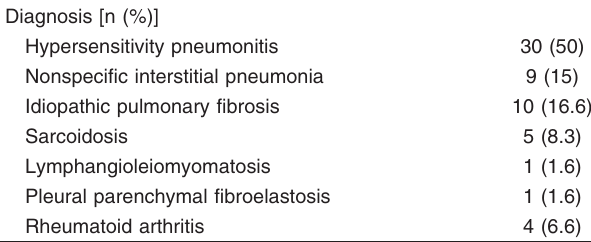
Table 3 The diagnosis of studied patients